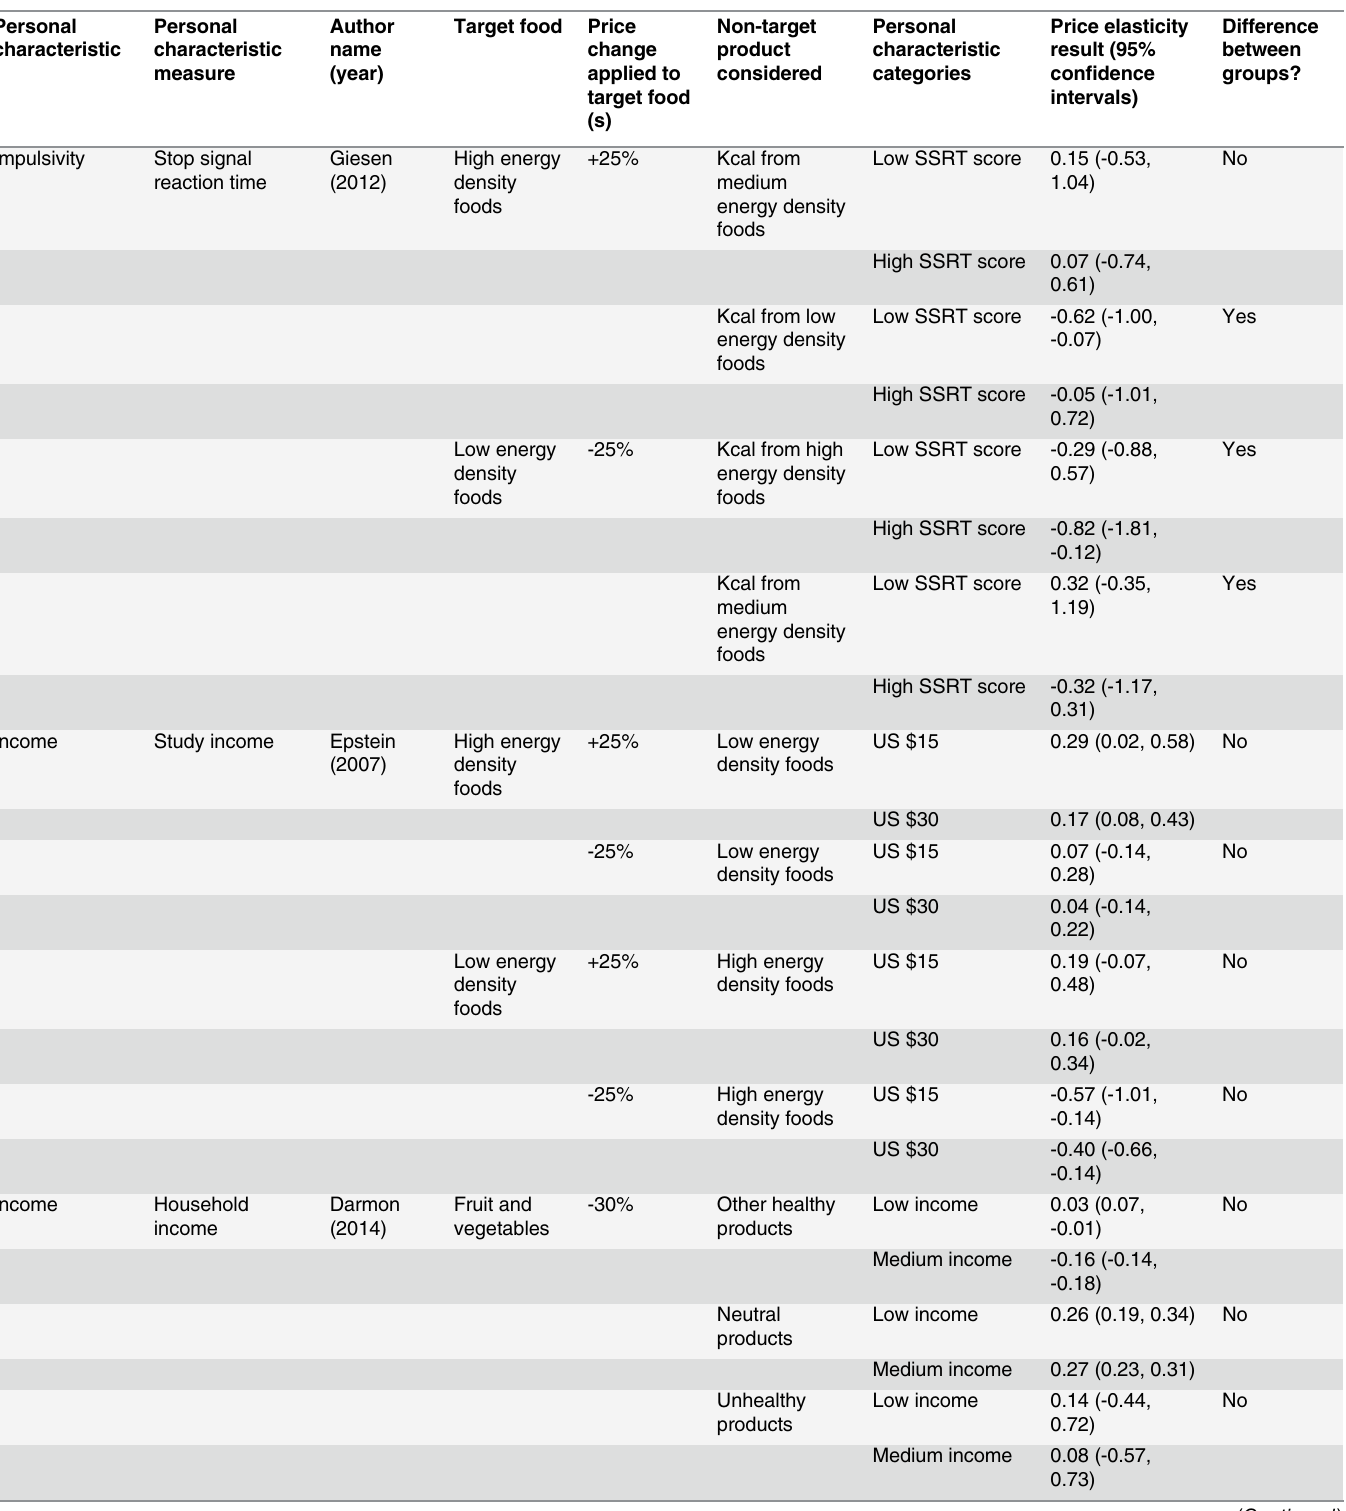
Table 4. Cross-price elasticities for non-target products by personal characteristic